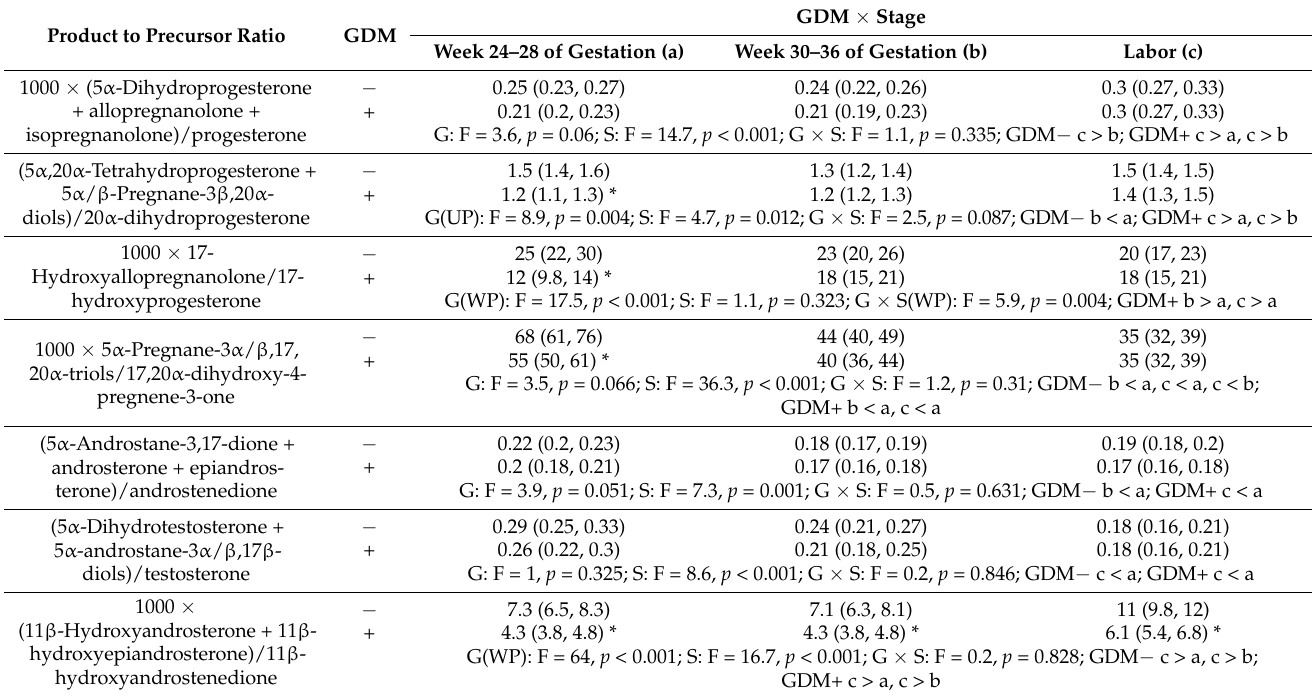
Table 4. Profiles of product to precursor ratios that may reflect the SRD5As activities in the GDM − and GDM+ groups from week 24 of gestation to